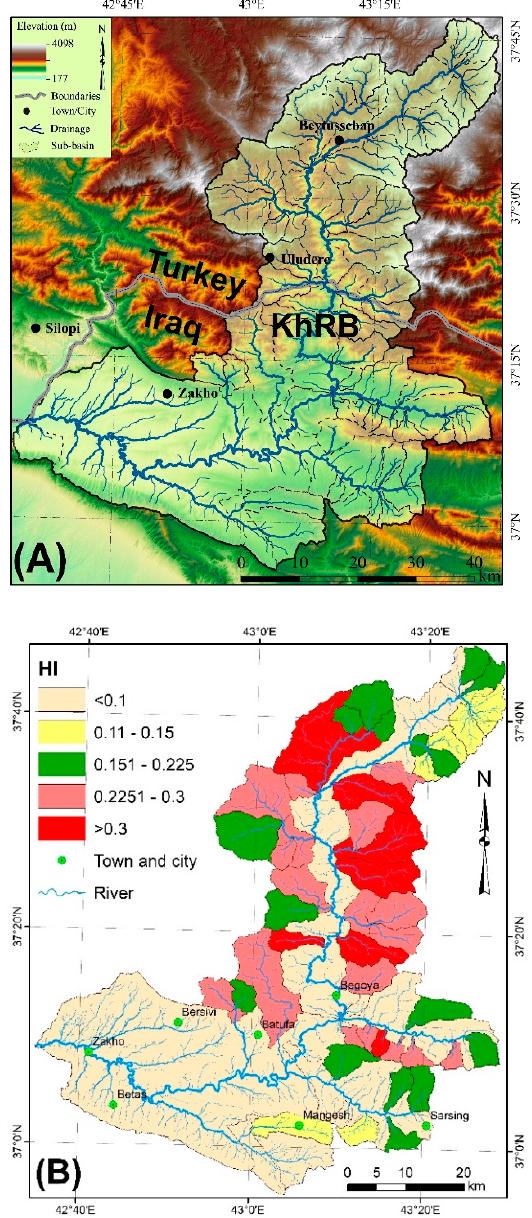
Figure 4. Map showing ( A ) the basins tested for estimating soil loss, and ( B ) the mean value of HI for each sub ‐ basin within the study area.